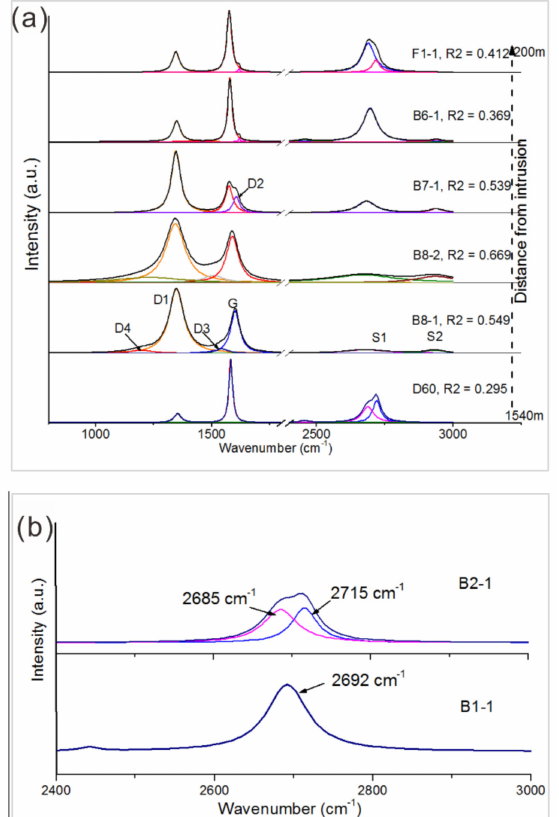
Figure 4. ( a ) Raman spectra of representative samples at di ff erent distances from the intrusion. ( b ) The second-region Raman spectra of samples F2-2 and B1-1, with sample F2-2 showing an asymmetric 2D 1 band that was separated into two bands at 2685 cm − 1 and 2715 cm − 1 , and sample B1-1 showing a symmetric and single 2D 1